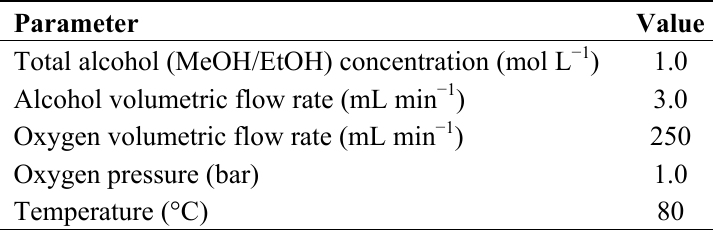
Table 1. Experimental conditions of